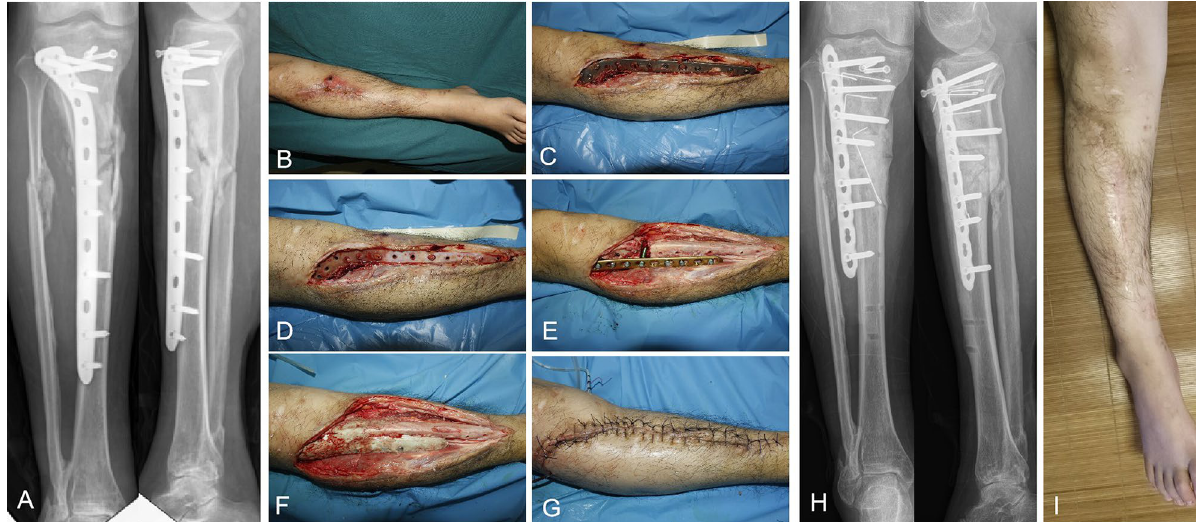
Figure 2. Typical case, Male, 25Y, repeatedly ulceration and pus of the right leg for 1 year, ( A ) X-rays showed bone destruction, ( B ) photo before operation, ( C ) and ( D ) infected tissue showed after removal of the internal fixation, E, bone defect was stabilized with LCP after debridement, ( F ) antibiotic cement filled the defect and wrapped the plate, ( G ) sutures the incision, ( H ) postoperative X-ray, ( I ) the incision healed at 6 months follow